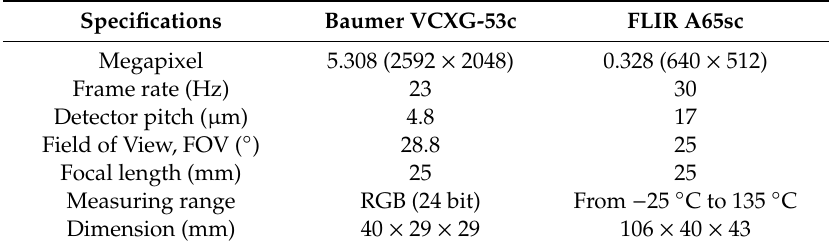
Table 1. Specifications of the used RGB and thermal cameras for